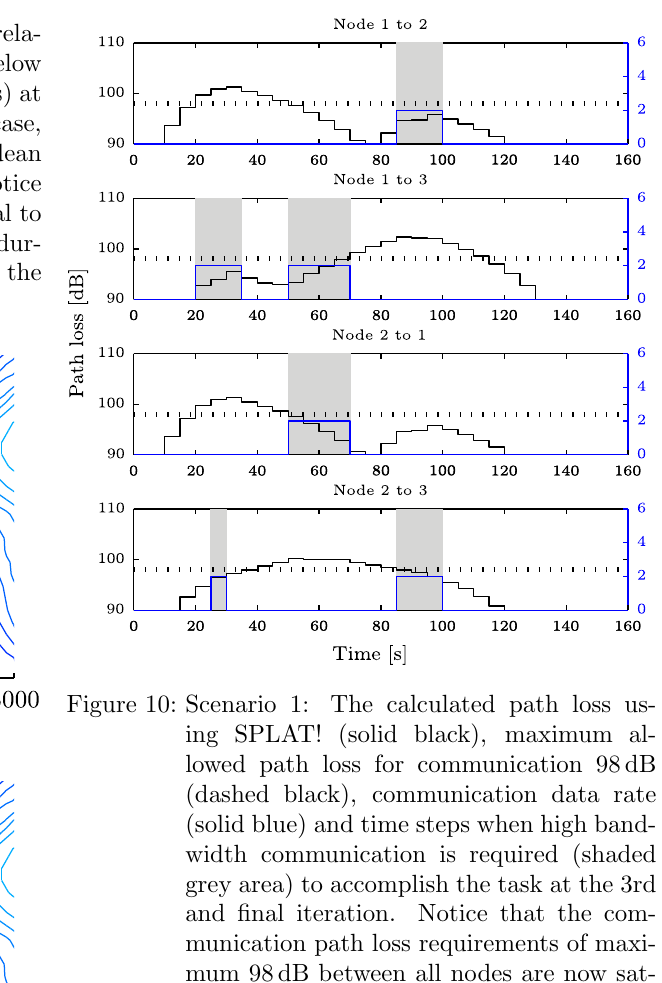
Figure 10: Scenario 1: The calculated path loss us- ing SPLAT! (solid black), maximum al- lowed path loss for communication 98 dB (dashed black), communication data rate (solid blue) and time steps when high band- width communication is required (shaded grey area) to accomplish the task at the 3rd and final iteration. Notice that the com- munication path loss requirements of maxi- mum 98 dB between all nodes are now sat-